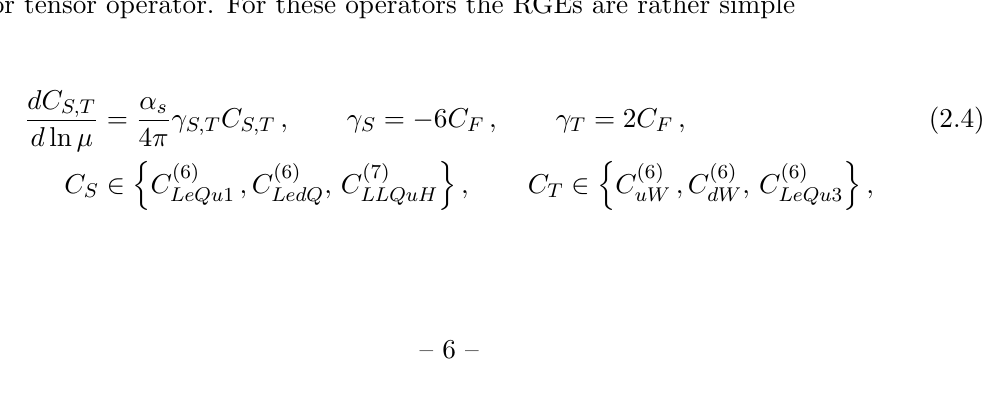
consider the RGEs due to one-loop QCD e(cid:11)ects. Most of the operators in tables 1{4 do not undergo QCD renormalization or consist of a quark bilinear and evolve either like a scalar or tensor operator. For these operators the RGEs are rather